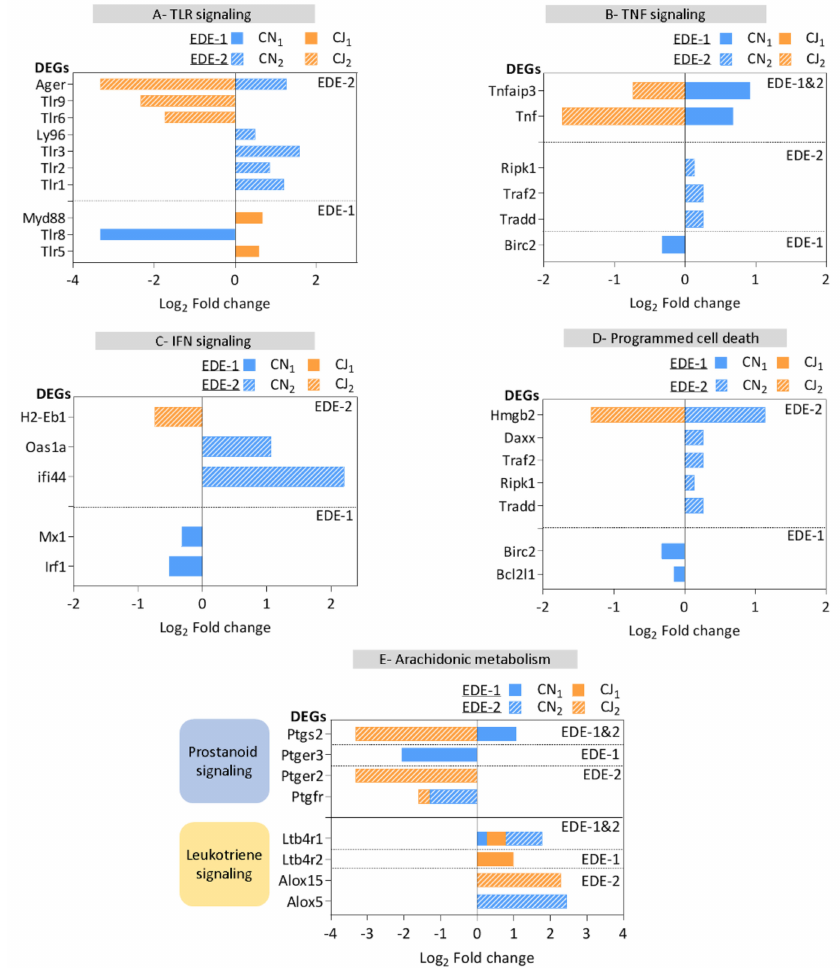
Figure 4. Main pathways involved in regulation of inflammatory status of both EDE models. Clus- tering of gene expression profiles highlights five signaling pathways: ( A ) Toll-like receptor (TLR) signaling; ( B ) tumor necrosis factor (TNF) signaling; ( C ) interferon (IFN) signaling; ( D ) programmed cell death (PCD); ( E ) arachidonic acid metabolism. Horizontal axis represents log2 fold-change difference between experimental models against healthy controls in each tissue: CN 1 (cornea), CJ 1 (conjunctiva) of EDE-1, and CN 2 (cornea) and CJ 2 (conjunctiva) of EDE-2. The hatched line separates EDE mice models DEGs’ specificities and